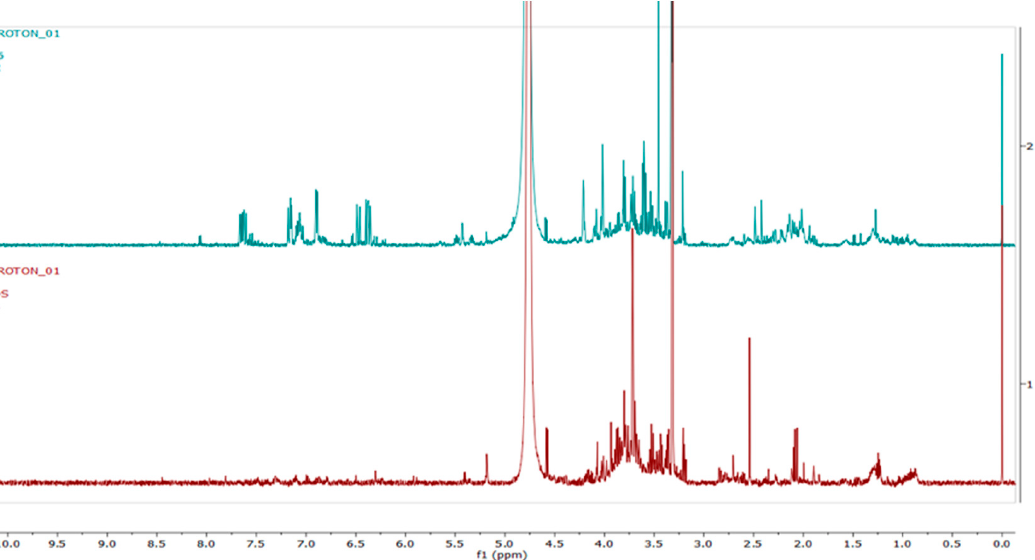
Figure 4. Comparison between samples harvested from dry sites in the spring season across the two locations on the basis of 600 MHz 1 H-NMR spectra of H. aureonitens leaf extracts. Red—spring season, site 3 (dry) Telperion; light blue—spring season, site 3 (dry) Wakefield.